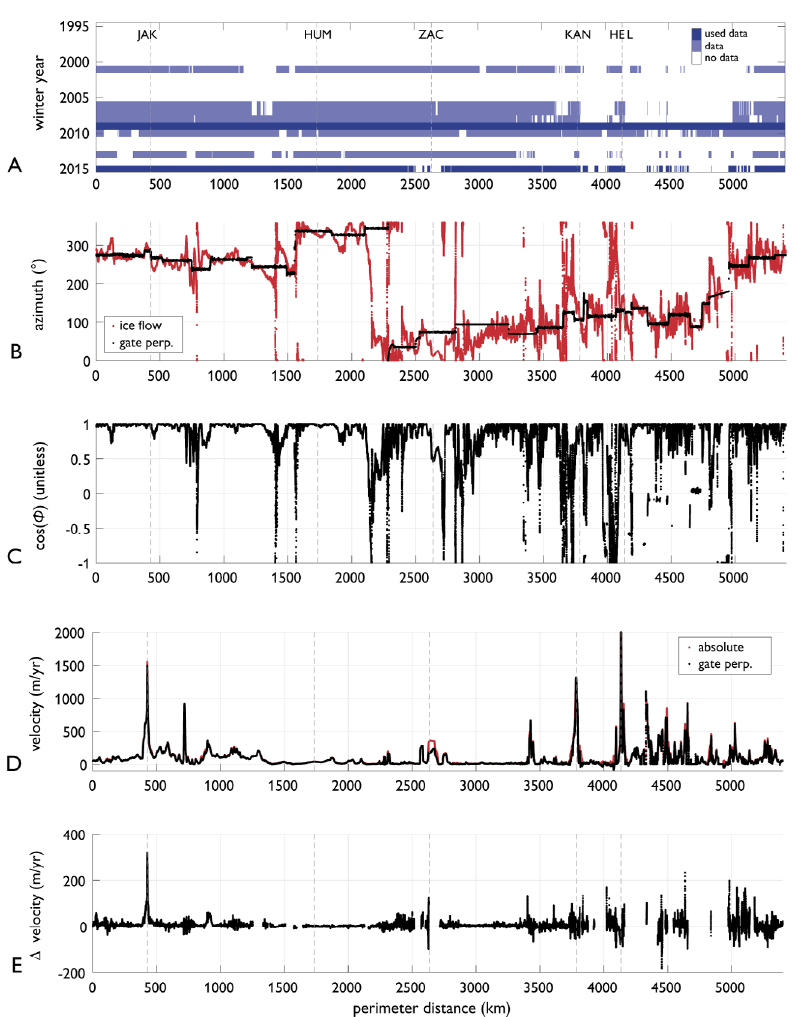
Fig. 3. A : Satellite-derived annual winter ice- velocity data availability along the PROMICE perimeter within the combined Joughin et al . (2010) and Rignot & Mouginot (2012) datasets during winters 1995–2015. B : 2008/2009 ice flow and gate-perpendicular azimuths around the PROMICE perimeter (Rignot & Mouginot 2012). C : Dimensionless scale factor ( cos ϑ ) of velocity magnitude. D : Absolute and gate-perpen- dicular surface velocity around the PROMICE perimeter. E : Changes in gate-perpendicular ice velocities surveyed in 2008/2009 and 2014/2015 (Joughin et al. 2010). In all subplots vertical dashed lines denote major glaciers (Fig.